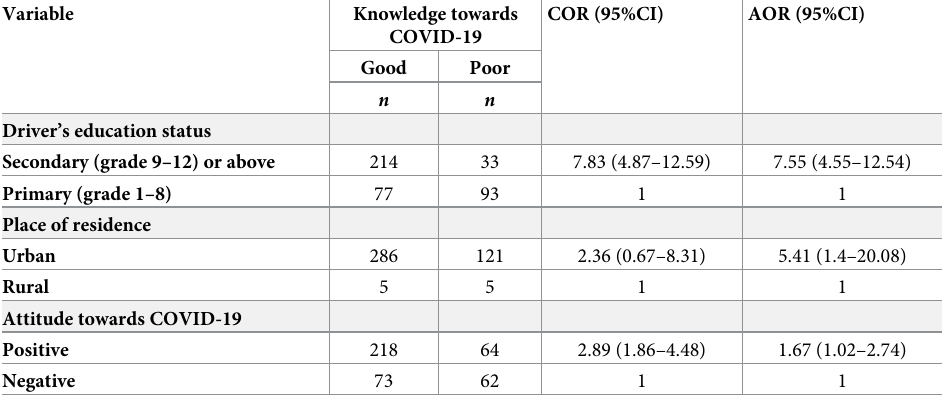
Table 5. Factors associated with good knowledge about COVID-19 among taxi drivers from multivariable analy- sis in Dessie City and Kombolcha Town, Ethiopia, July to August 2020.